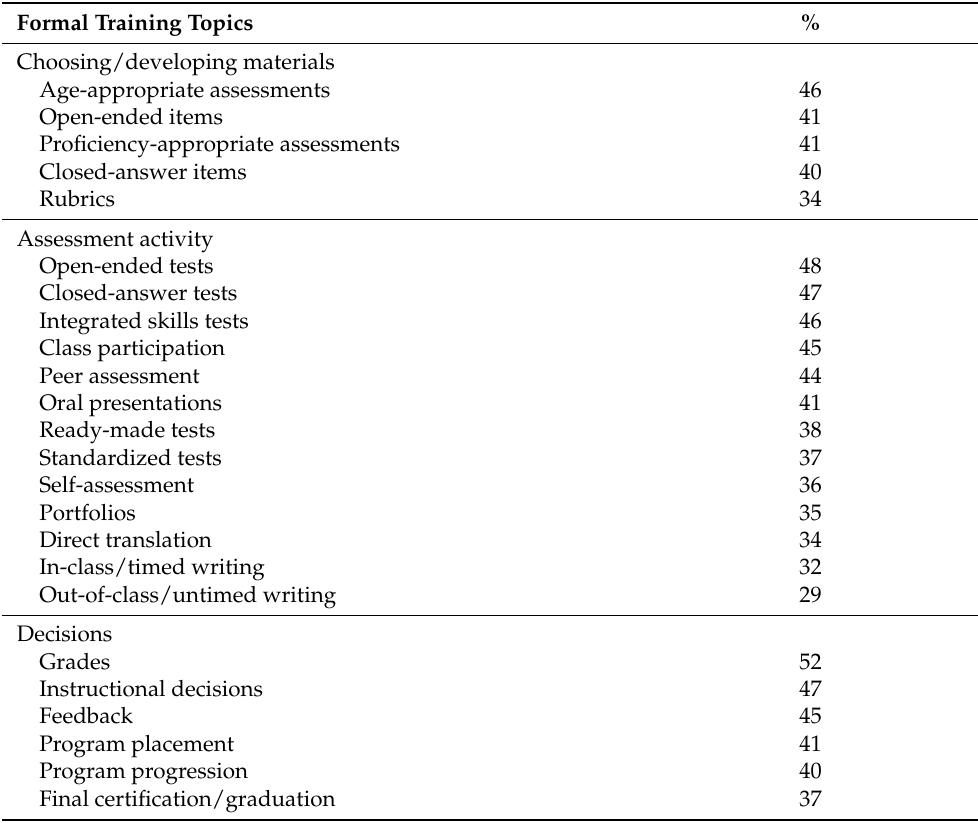
Table 4. Topics covered in formal training by % received training (N =